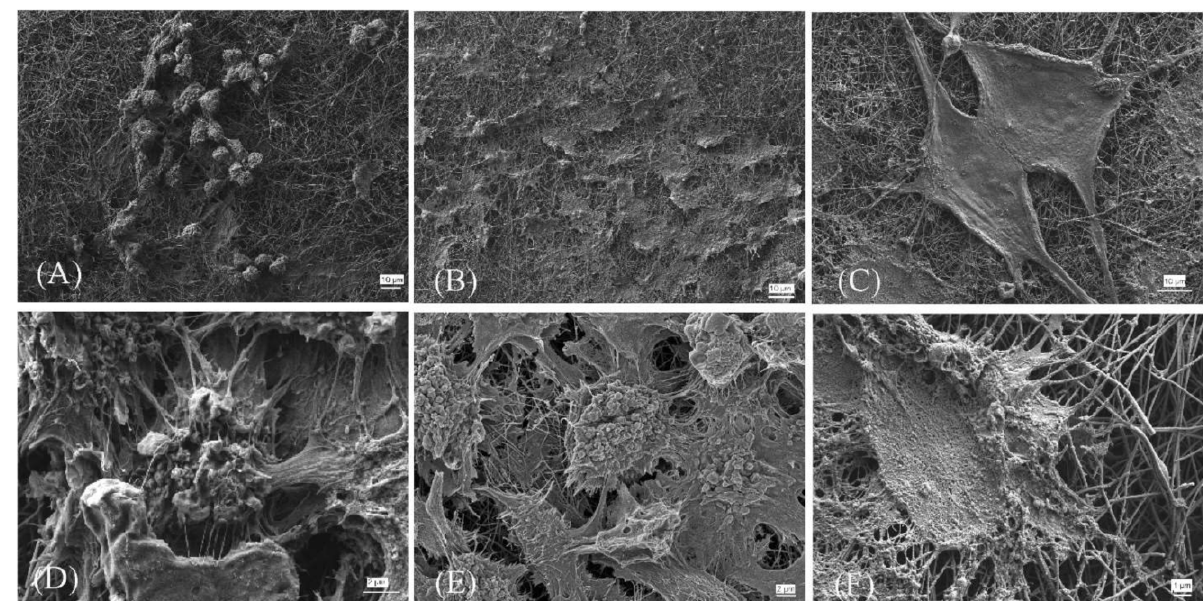
Figure 8. SEM images of the fibroblast cells grown on the prepared samples (CNF, CNF/8HA, and CNF/8HA (hydrother- mally)) after seven days with low magnification ( A – C ) and high magnification ( D – F